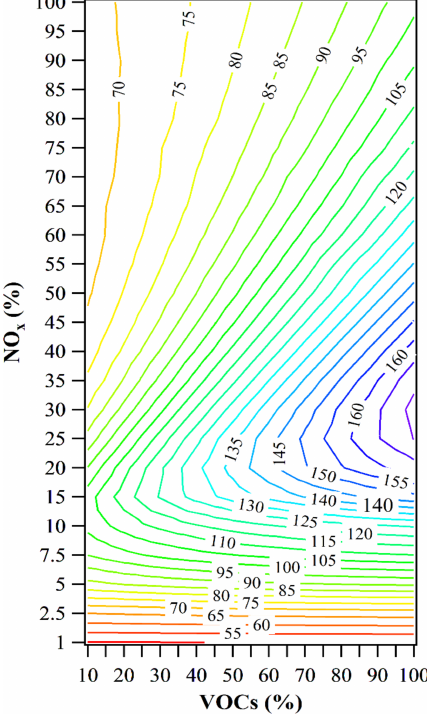
Figure 9. The O 3 isopleth in term of percentage changes of volatile organic compounds (VOCs) and NO x : the percentage change of NO x from 0% to 99% and the percentage change of VOCs from 0% to 90%. The O 3 mixing ratios are inppbv. The horizontal and vertical axes correspond to the percentage of the measured average mixing ratios of VOCs and NO x , respectively.